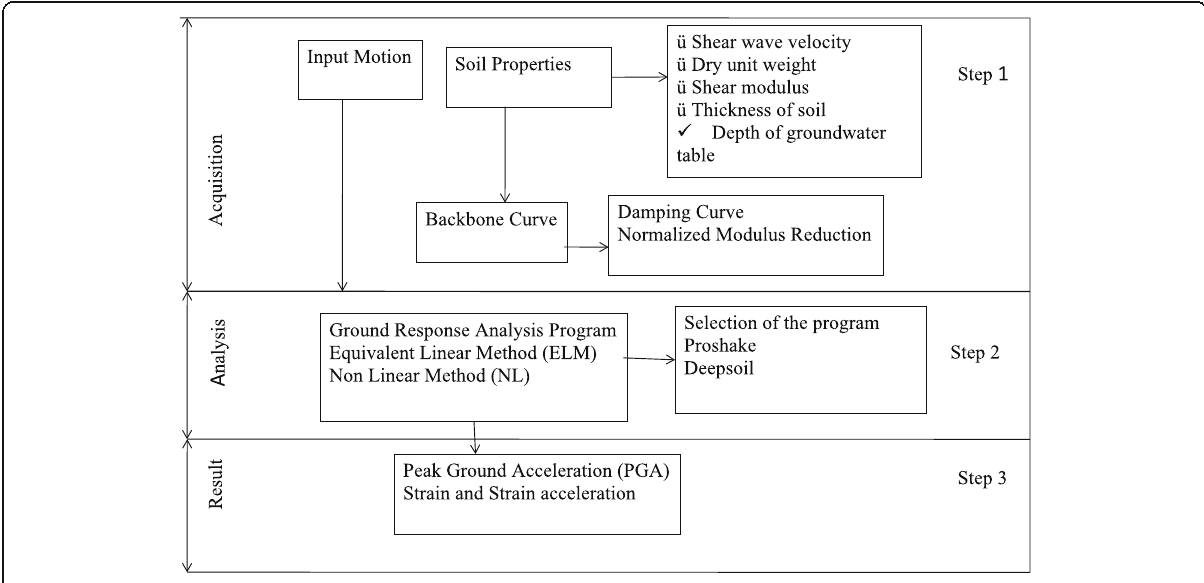
Fig. 9 Steps to be followed for the site response analysis (modified after Anbazhagan 2013; Eko and Eric